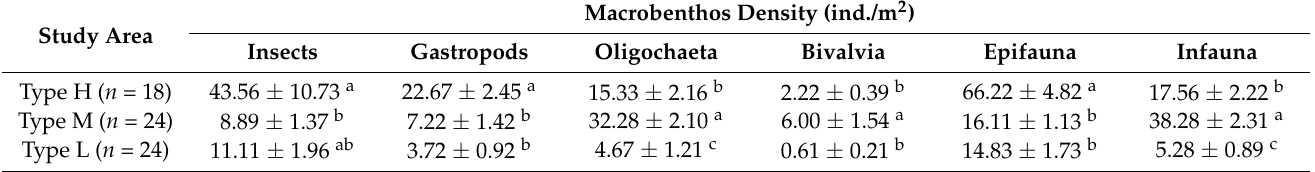
Table 1. Density (ind./m 2 ) of four taxa of different macrobenthos and two life-forms in three study areas.